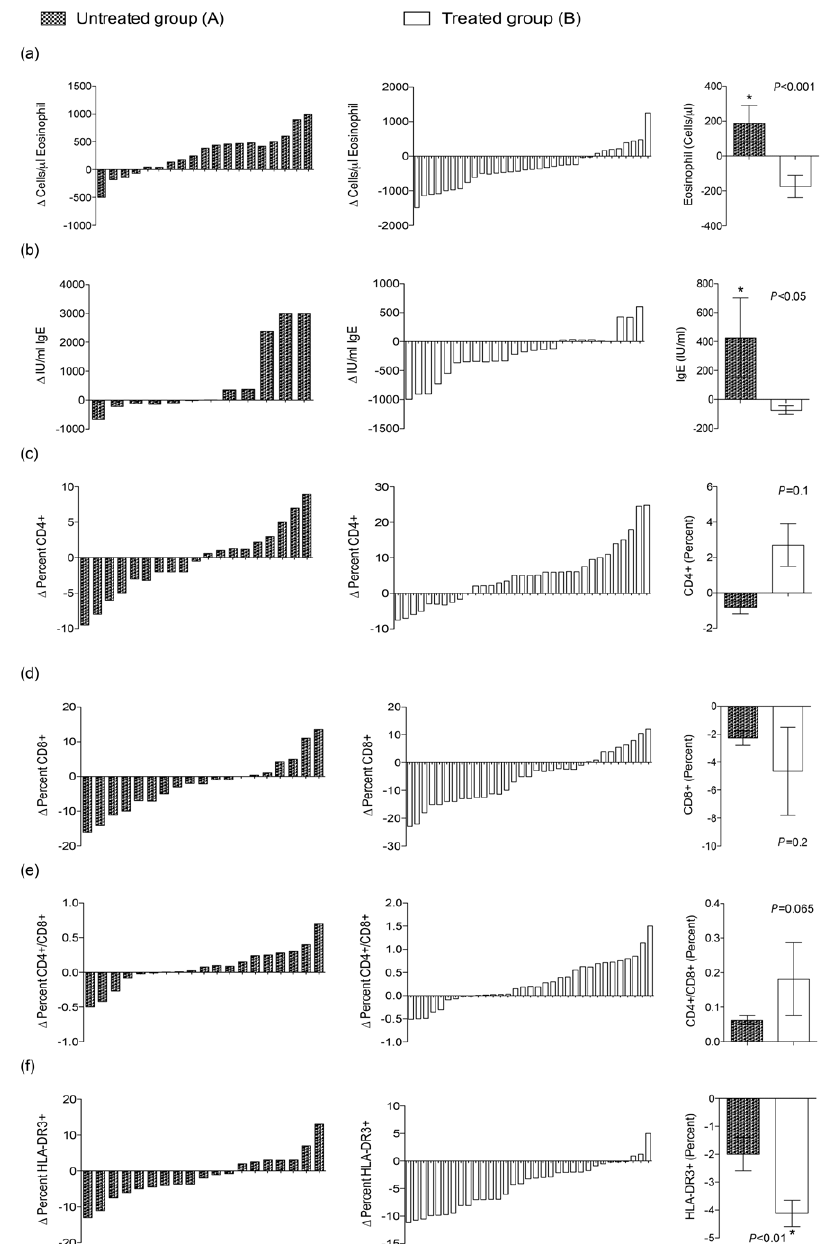
Figure 1. Relative changes (RCs) of the immunological parameters measured in the 2 groups A and B (untreated versus treated) before and after treatment, at baseline (X1) and at 6 to 12 months later (X2) was calculated as follows: RC = [(X -X )/X ] x100. For each parameter denoted in lower case alphabets (a to f), 2 1 1 the results of the 2 groups (A and B) are presented in parallel. The right panel is the comparison between the cross-sectional mean ± SE of the RCs in the immunological parameters of the 2 groups (A versus B). The P value determined by the Mann Whitney rank test is shown. ( P < 0.05 is statistically